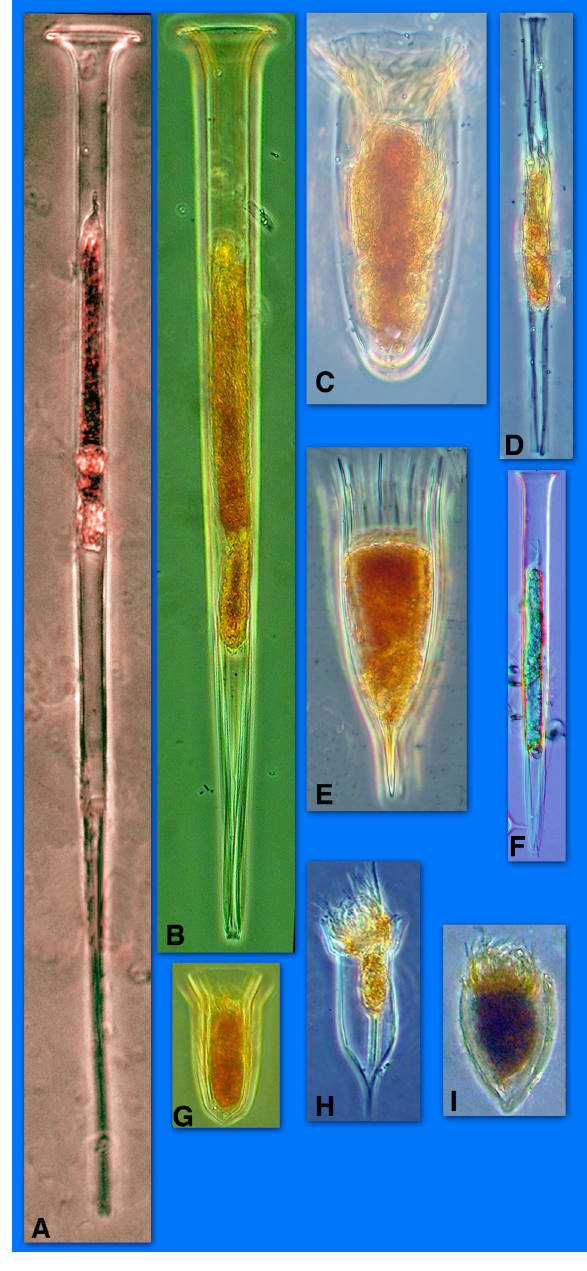
the stations sampled: Salpingella attenuata (A) , Salpingella acumi- nata (B) , Amphorella ( Amphorides ) quadrilineata (C) , Salpingella faureii (D) , Dadayiella ganymedes (E) , Salpingella decurtata (F) , Cantheriella pyrimidata (G) , Ormsella trachelium (H) , Protorhab- donella simplex (I) . Dadayiella ganymedes (E) is 100 µ m in total length. Note that these wide-spread species do not share any obvi- ous morphological